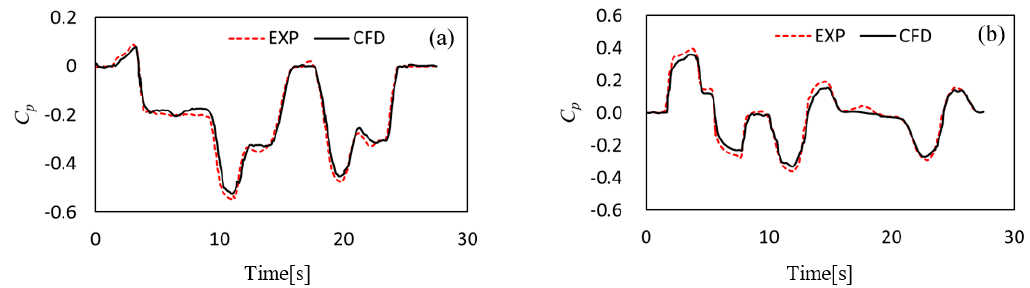
Figure 10. Comparison of the real train experiment and simulation: ( a ) On the train body; ( b ) on the inner wall of the tunnel.